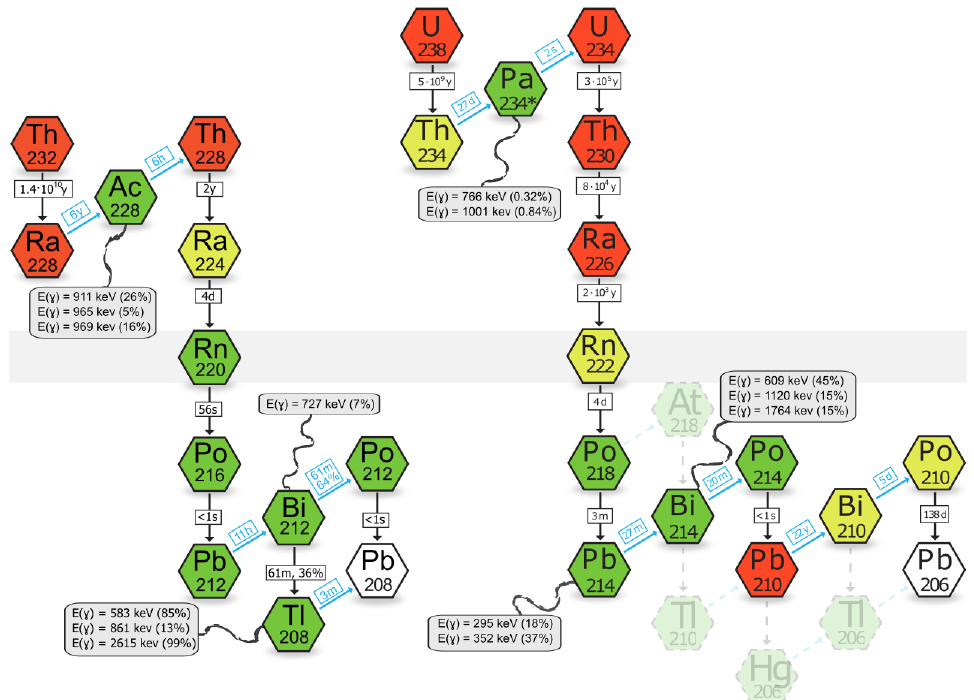
Figure 1. Radioactive chains. Left : 232 Th decay chain; Right : 238 U decay chain. In the grey boxes the most important gamma peaks energies and decay probabilities of the corresponding isotopes are